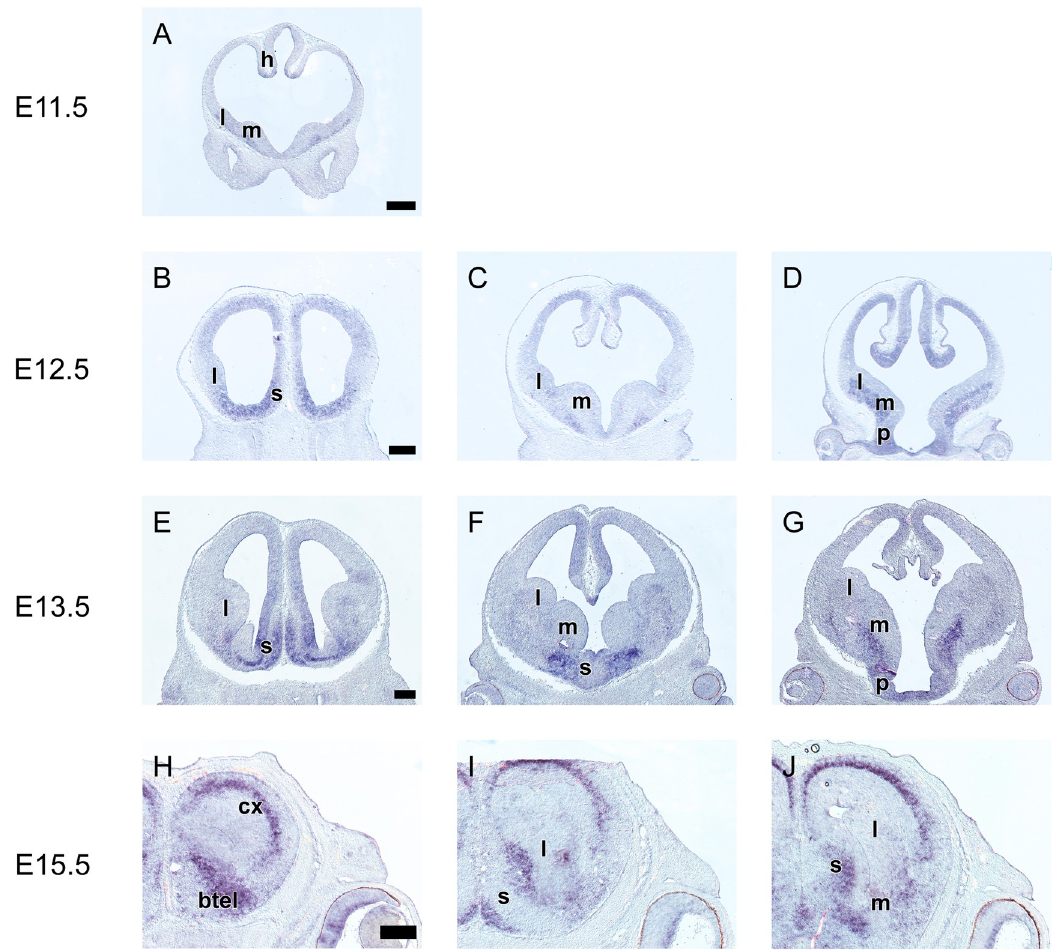
Fig 5. In situ hybridization on coronal sections through the embryonic telencephalon from rostral (left) to caudal (right) levels hybridized with an antisense RNA probe Grg4 at E11.5 (A), E12.5 (B—D), E13.5 (E-I) and E15.5 (H—J) m: MGE, l: LGE, l: LGE, s: septum. Scale: 250 μ